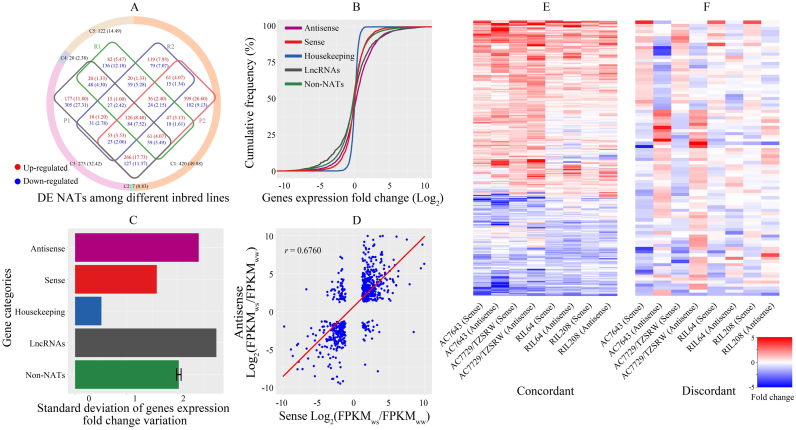
Response of natural antisense transcript (NAT) pairs to drought stress. (A) Differentially expressed (DE) NATs among the tested lines with different levels of drought sensitivity. The colored rings represent the numbers and percentages (%) of DE NATs between different samples. C1: Up- or down-regulated DE NATs in both the two drought tolerant lines and the two drought sensitive lines. C2: Up-regulated DE NATs in the two drought tolerant lines, but down-regulated in the two drought sensitive lines, or vice versa. C3: Up- or down-regulated DE NATs in one of the drought tolerant lines and also in one of the drought sensitive lines. C4: Up- or down-regulated DE NATs in one of the drought tolerant lines, but down- or up-regulated in one of the drought sensitive lines. C5: No significant expression changes. The Venn diagram of the DE NATs is in the center of the circle. P1: AC7643. P2: AC7729/TZSRW. R1: RIL208. R2: RIL64. The up- and down-regulated NATs are presented by red and blue colors, respectively. (B) Cumulative frequency distribution of gene expression fold change under water stress. Different colors indicate different groups of genes. Antisense transcript (n = 3948), sense transcript (n = 3884), housekeeping genes (n = 2328), lncRNAs of maize (n = 1550) and non-NATs in the maize transcriptome (n = 112 636) are depicted in dark pink, vivid red, dark blue, dark grey and dark cyan, respectively. The color code is displayed in left corner. (C) Standard deviation of fold change variation in gene expression. (D) Expression correlation of sense and antisense transcription in NAT pairs in response to water stress. Portrayed are the 516 NAT pair genes with at least a twofold expression increase or decrease under water stress. For each NAT pair, expression fold change under water stress (WS) and well water (WW) for the sense transcript was plotted against the antisense transcript. (E and F) Concordant and discordant NAT pairs with respect to response to drought stress, respectively.